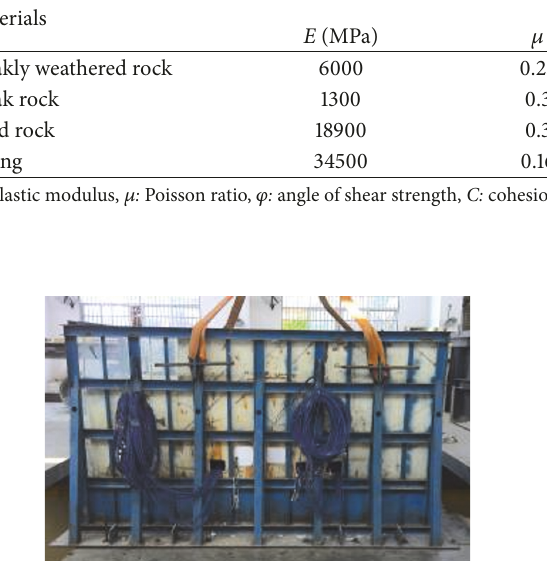
Figure 1: Rigid model box.